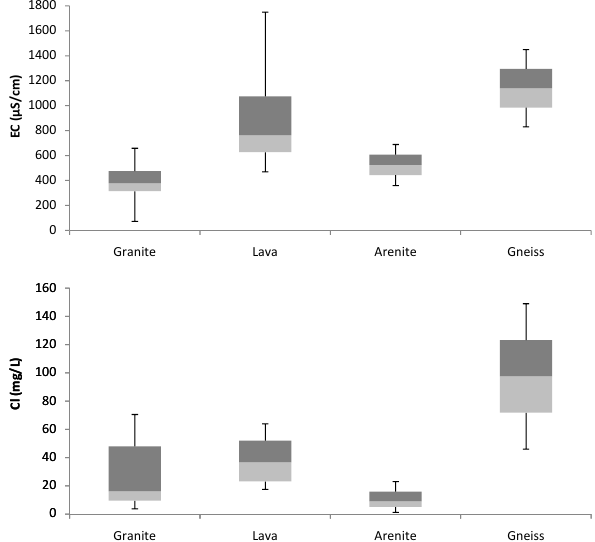
Figure 6. Boxplots of borehole water quality parameters at different geological locations in the Kaap